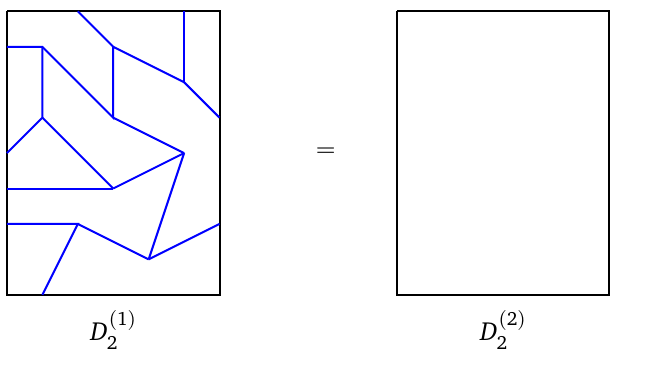
by gauging algebra A p 1,2 q 2 , while the 1